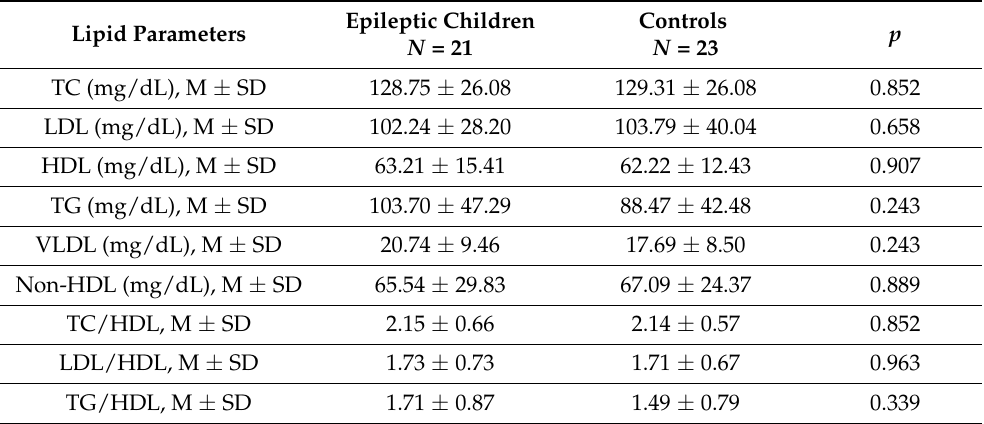
Table 3. Levels of lipid parameters in analyzed groups. Lipid Parameters